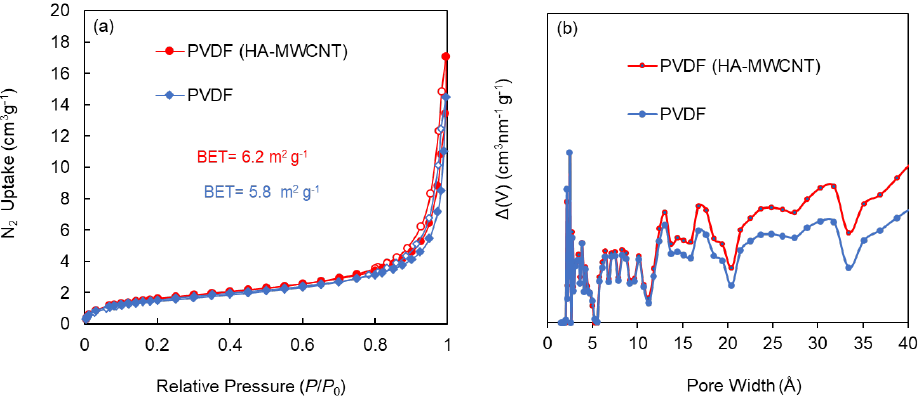
Figure 8. ( a ) N 2 sorption isotherms at 77 K for HA-MWCNT (red) and pristine PVDF (blue). ( b ) Pore size distribution of HA-MWCNT (red) and pristine PVDF (blue).